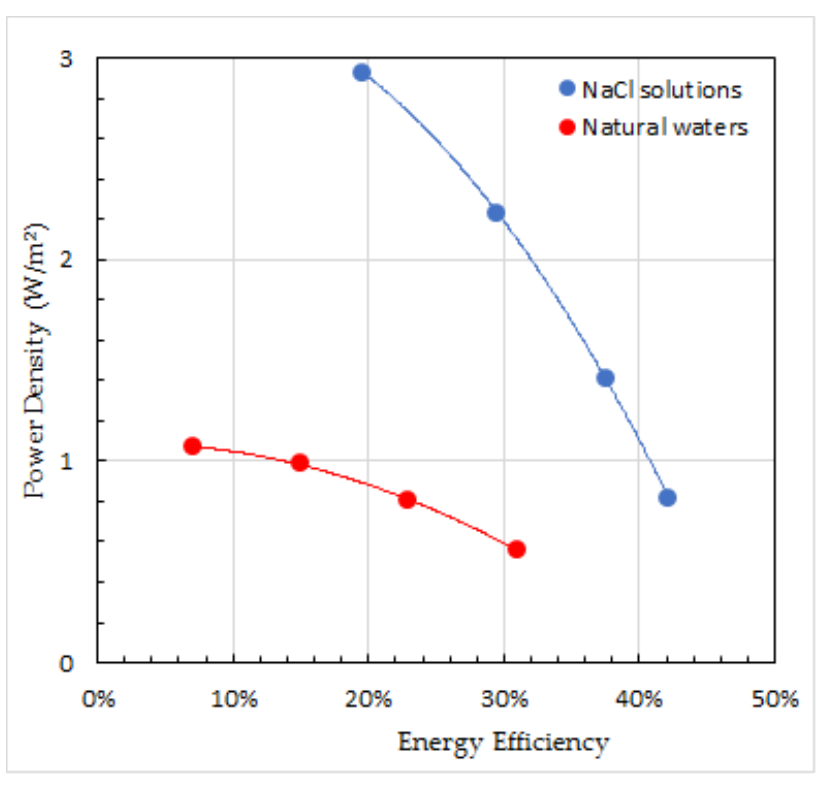
Figure 13. Relationship between power density and energy efficiency. The same RED stack is fed with pure NaCl solutions (blue line) and with water from the Wadden Sea and the Lake IJssel (red line). Parabolic regression lines are added to the plots.